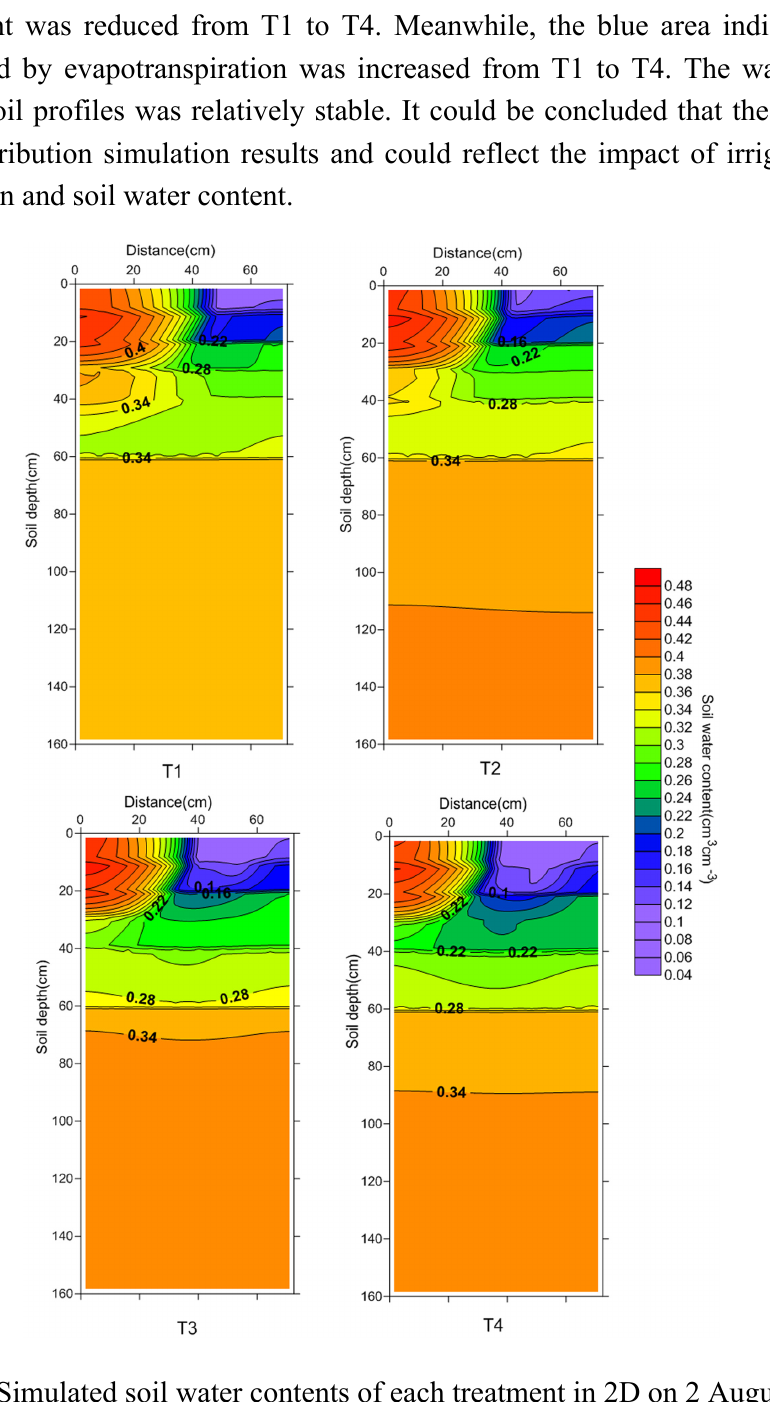
Figure 7. Simulated soil water contents of each treatment in 2D on 2 August